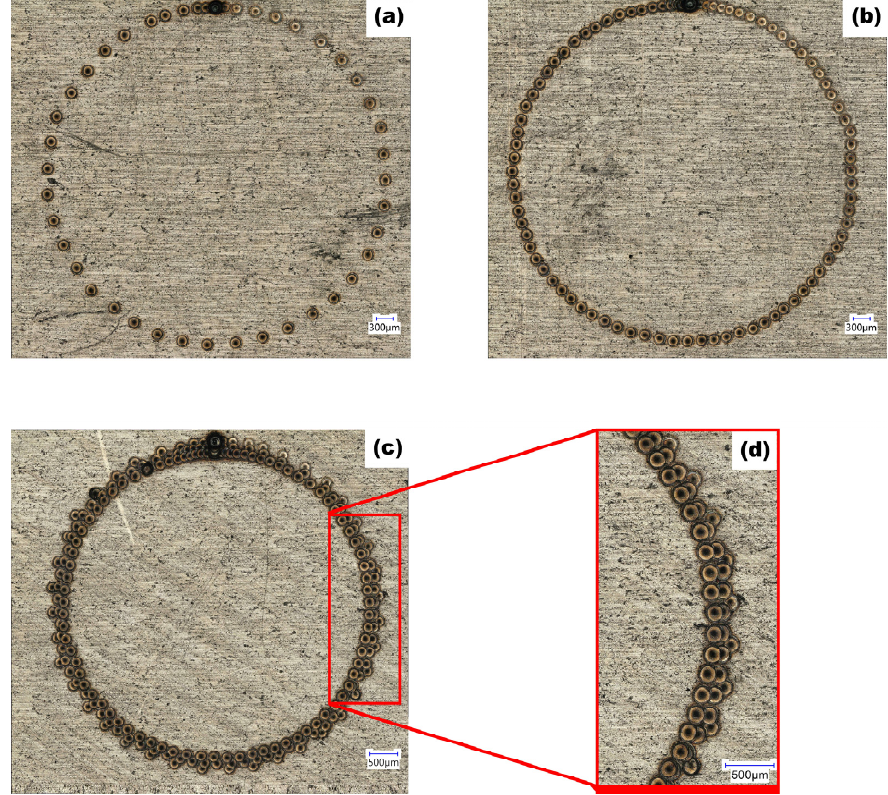
Figure 5. Pulse separation and overlaps with single-ring and multiple-ring drilling strategy: ( a ) 100 Hz pulse, single ring; ( b ) 200 Hz pulse, single ring. Three rings approach with 100 Hz and 200 Hz pulses: ( c ) H 1 = H 2 = 100 μ m; ( d ) close up view of multiple-ring overlap at 100 Hz and 200 Hz pulses.